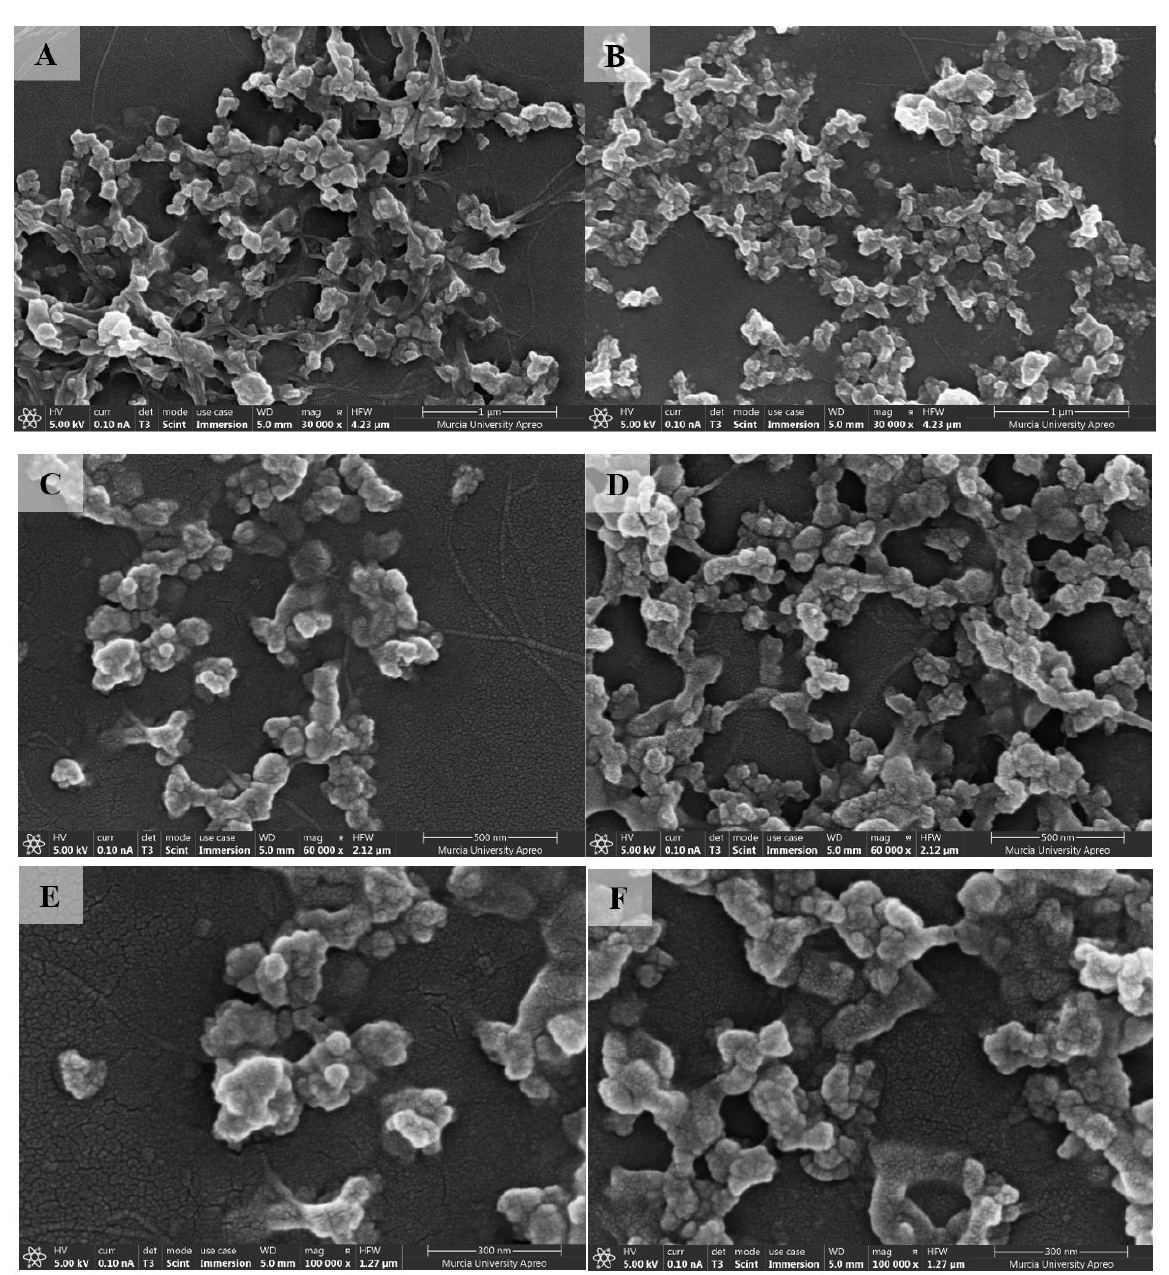
Figure 3. FESEM picture of ( A ) CNP-2A, ( B ) CNP-1F (30,000×), ( C ) CNP-2A, ( D ) CNP-1F (60,000×) and ( E ) CNP-2A, ( F ) CNP-1F (100,000×).